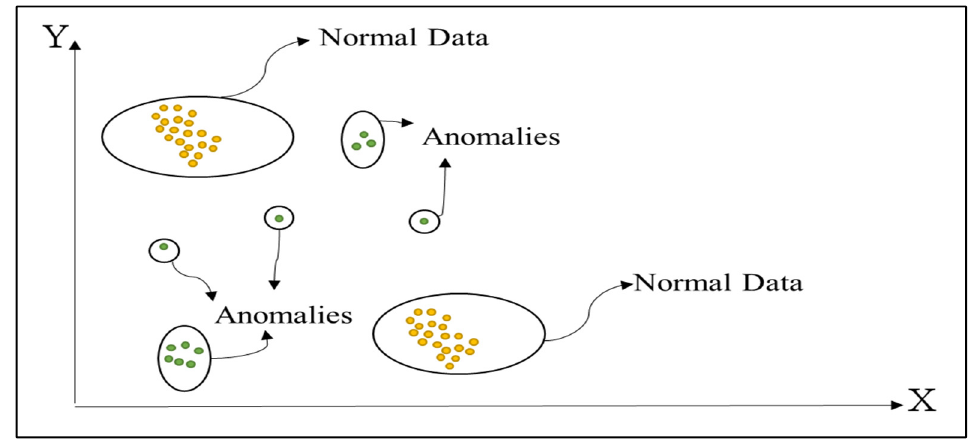
Figure 2. An example of anomaly in a dataset.